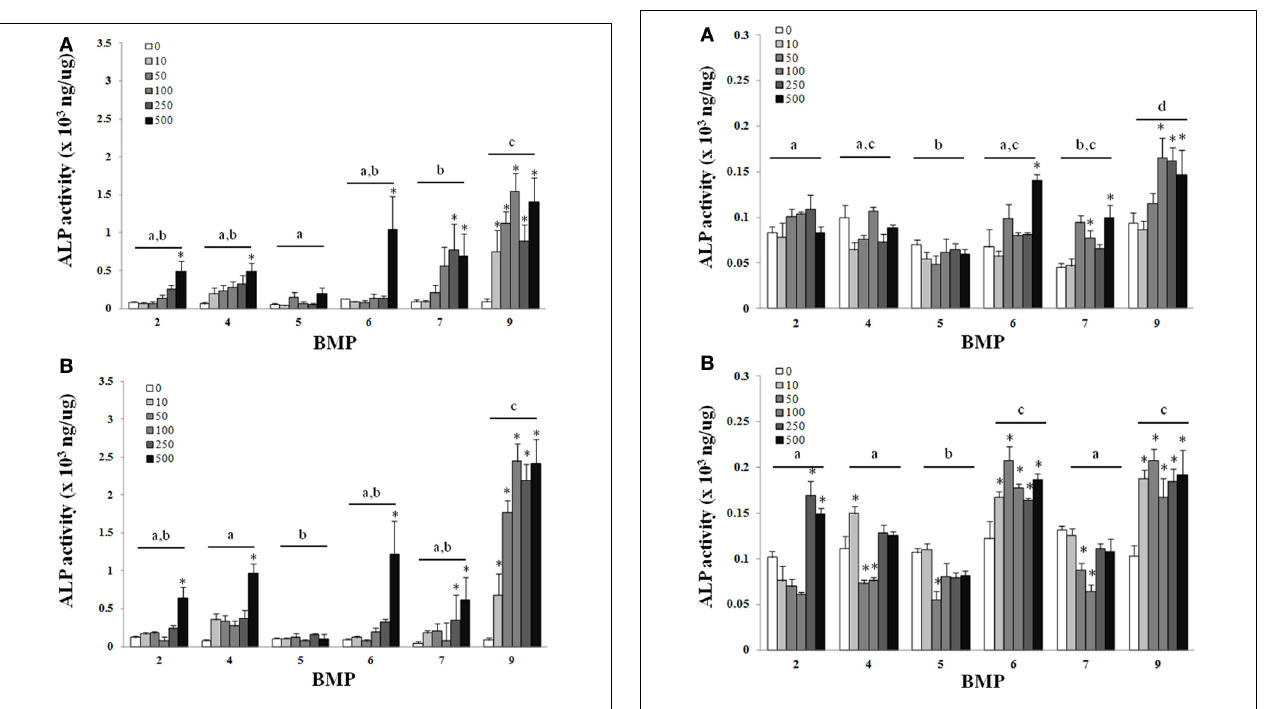
FIGURE 2 | Adipose-derived stem cells (ASCs) were treated with BMP-2,- 4,-5, -6, -7, or -9 for 3 days and lysed on day 3 (A) or 7 (B) after the initiation of treatment. Error bars are ± SEM. Different letters signify a difference among groups, p ≤ 0 . 05. ∗ Significantly different control (0ng/ml BMP) within group, p ≤ 0 .